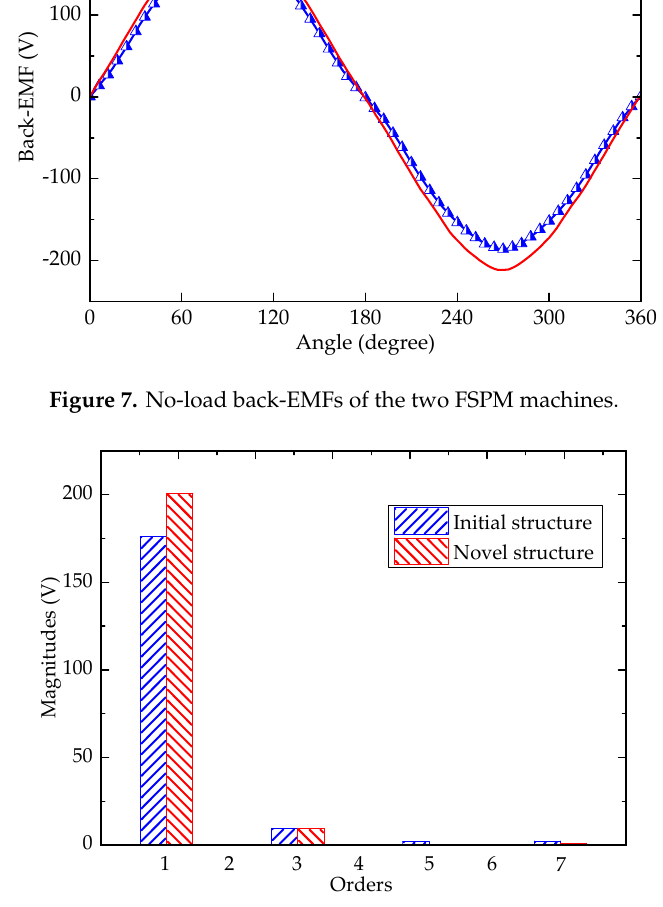
Figure 8. Fast Fourier transform (FFT) results of back ‐ EMFs of the two FSPM machines.